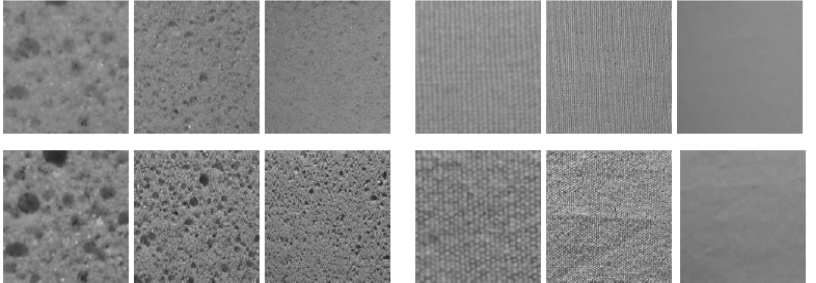
Figure A5. A subset of KTH-TIPS dataset showing six examples from each of two classes: sponge (left) and cotton (right). The six examples include two different illuminations and three different scales.